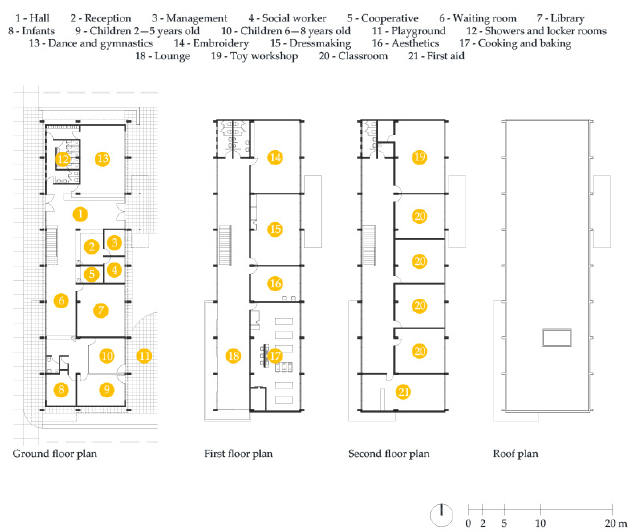
Figure 10. Floor plans and program distribution of the Casa de la Asegurada at the Unidad Indepen- dencia housing complex. Source: own creation, 2021.